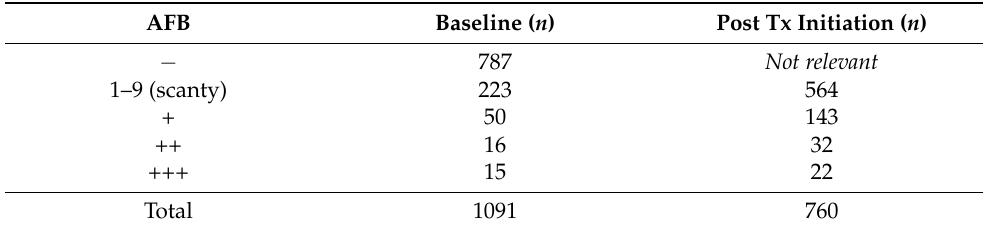
Table 1. Numbers of patients in our cohort ( n = 5192) with a culture-negative sputum sample at baseline and/or smear-positive/culture-negative sample post treatment, stratified by AFB smear results. AFB: acid-fast bacilli; tx: treatment. AFB